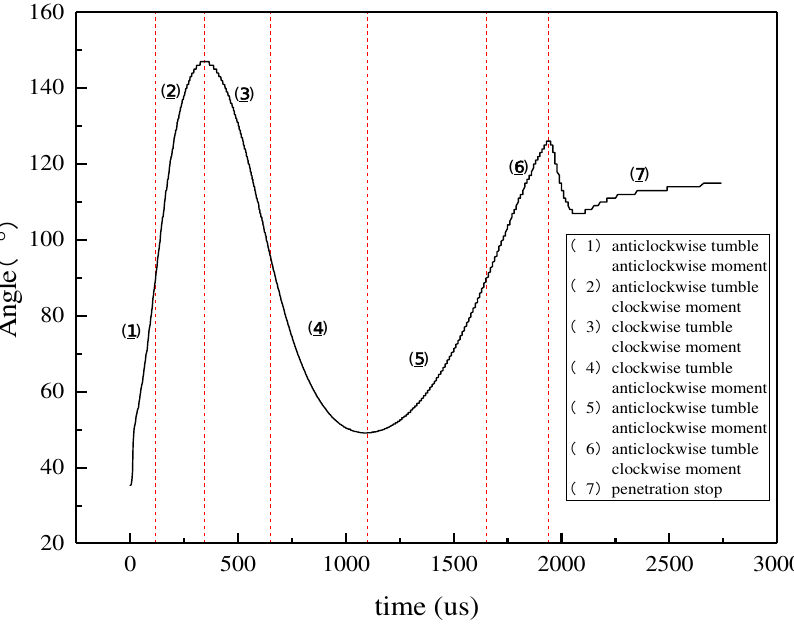
Figure 9. Attitude angle change of projectile in Test 3. (The red dash line is the dividing line of different stages).